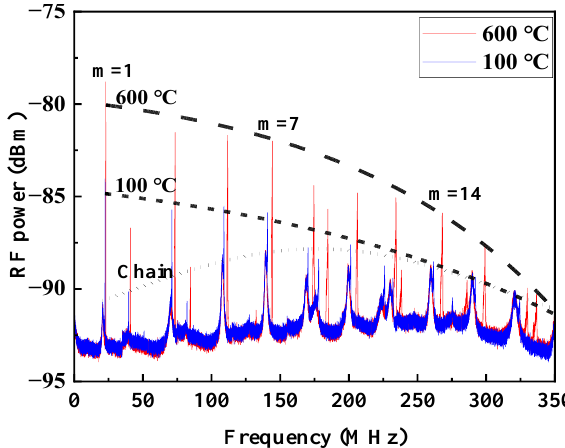
Figure 7. Measured depolarized GAWBS spectra at 100 °C and 600 °C, respectively.